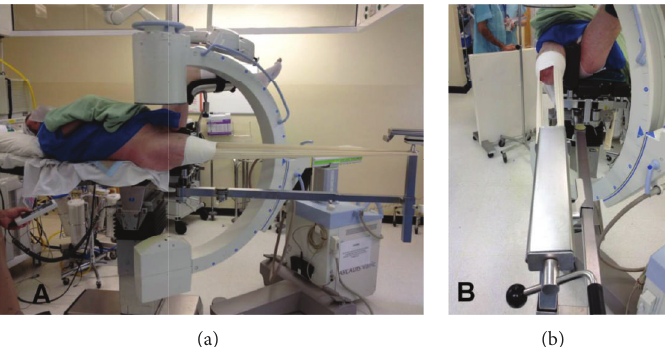
Figure 2: Intraoperative photographs demonstrating the setup of the patient on the fracture table with the amputated limb secured with adhesive fabric